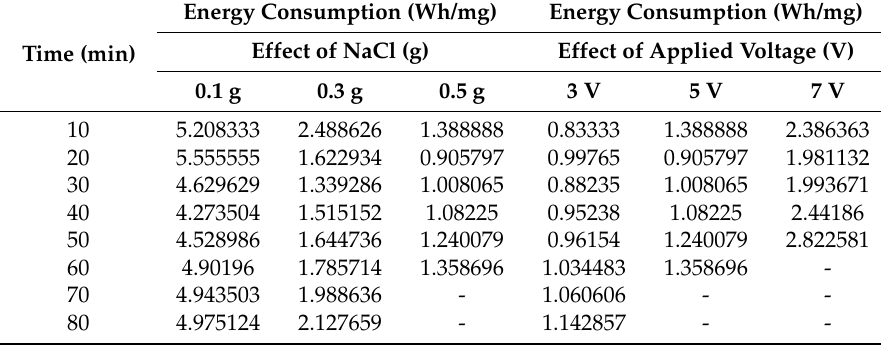
Table 1. Energy consumption of HDZ under effect of sodium chloride and applied voltage. Effect of NaCl Time (min) Energy Consumption (Wh/mg) Energy Consumption (Wh/mg) Time (min)